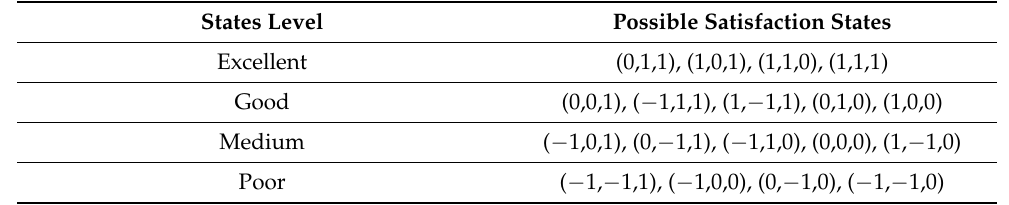
Table 1. Conditional state satisfies level